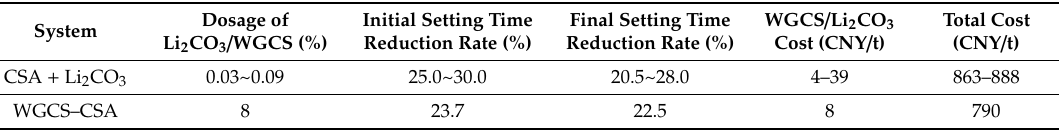
Table 8. Cost of CSA and WGCS–CSA